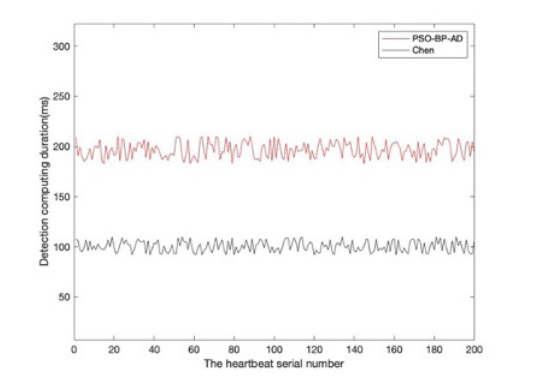
Fig. 5. Comparison of heartbeat time delay.